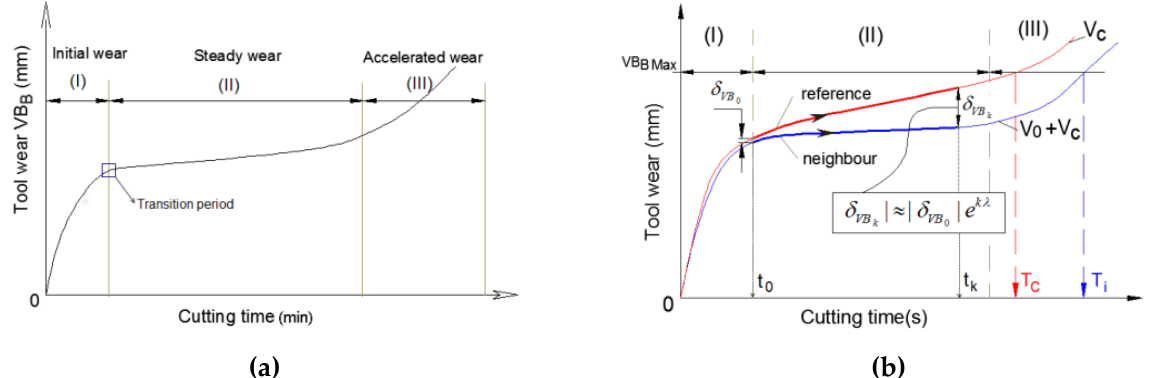
Figure 6. ( a ) Three distinctive tool wear periods; ( b ) chaos theory: a small change in the initial period can result in a big change in the entire process [21].